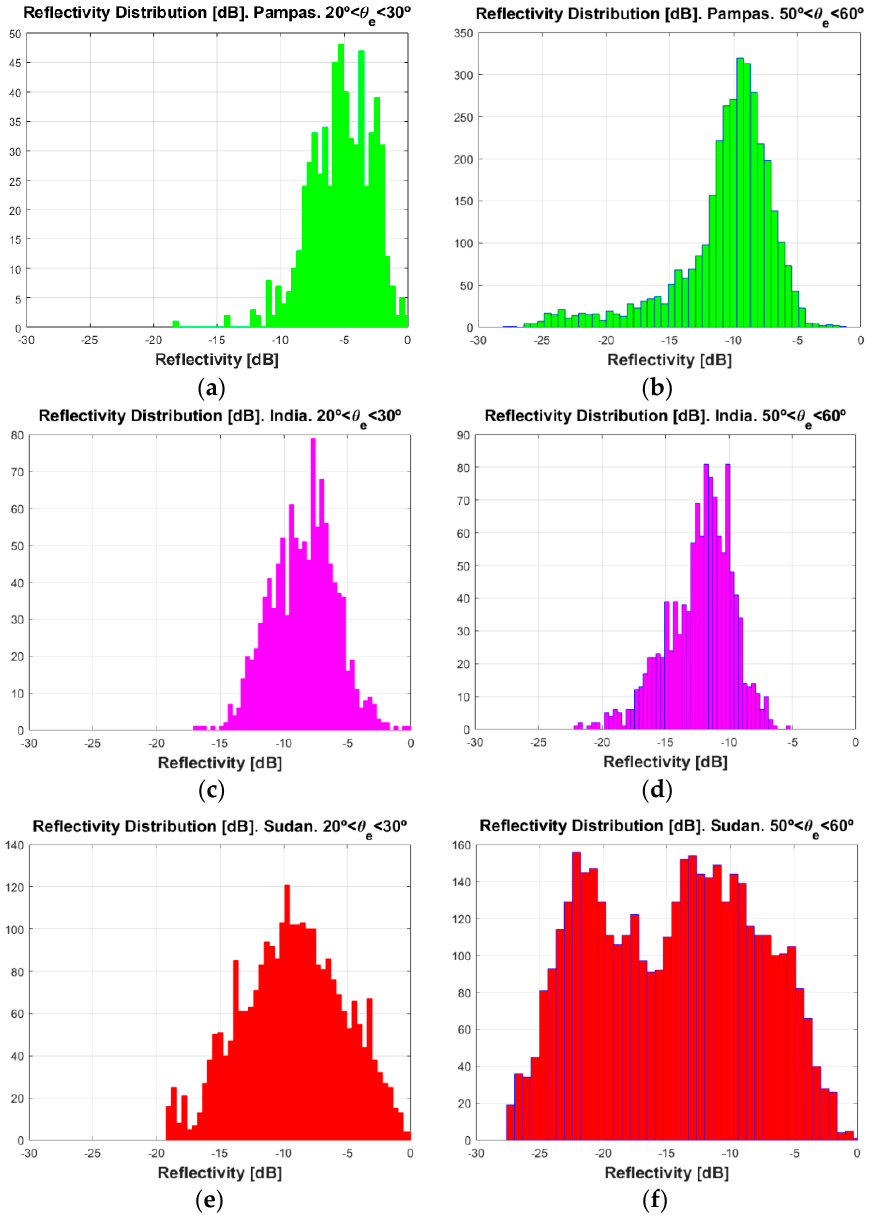
Γ over the selected target areas [( a , b ) LHCP,CyGNSS θ = [20,30]°, and (b,d,f) θ = [50,60]°. e e